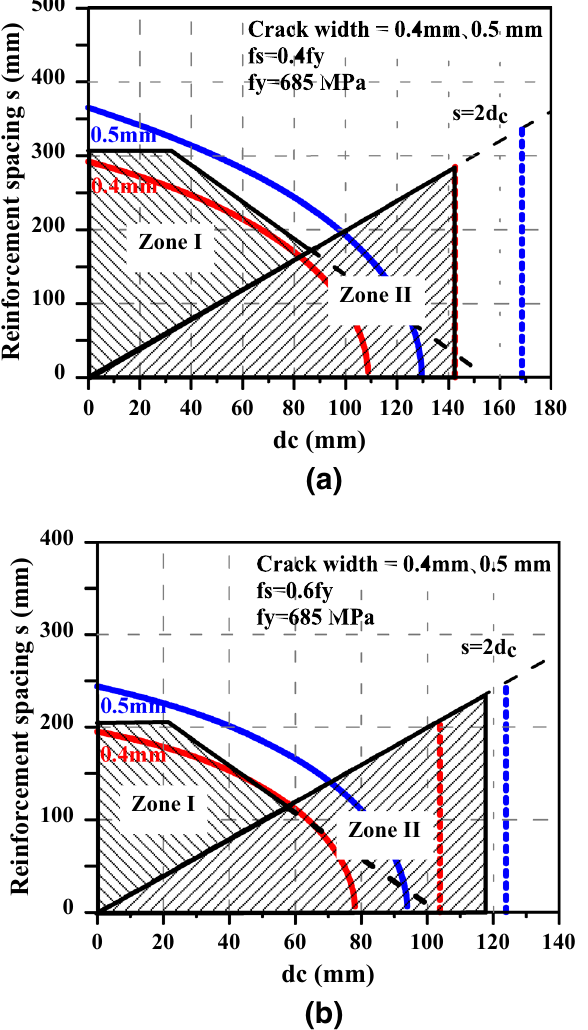
Fig. 20 Deign equations in ACI 318-14 for the flexural crack width control. a f s = 0.4f y and b f s = 0.6f y .